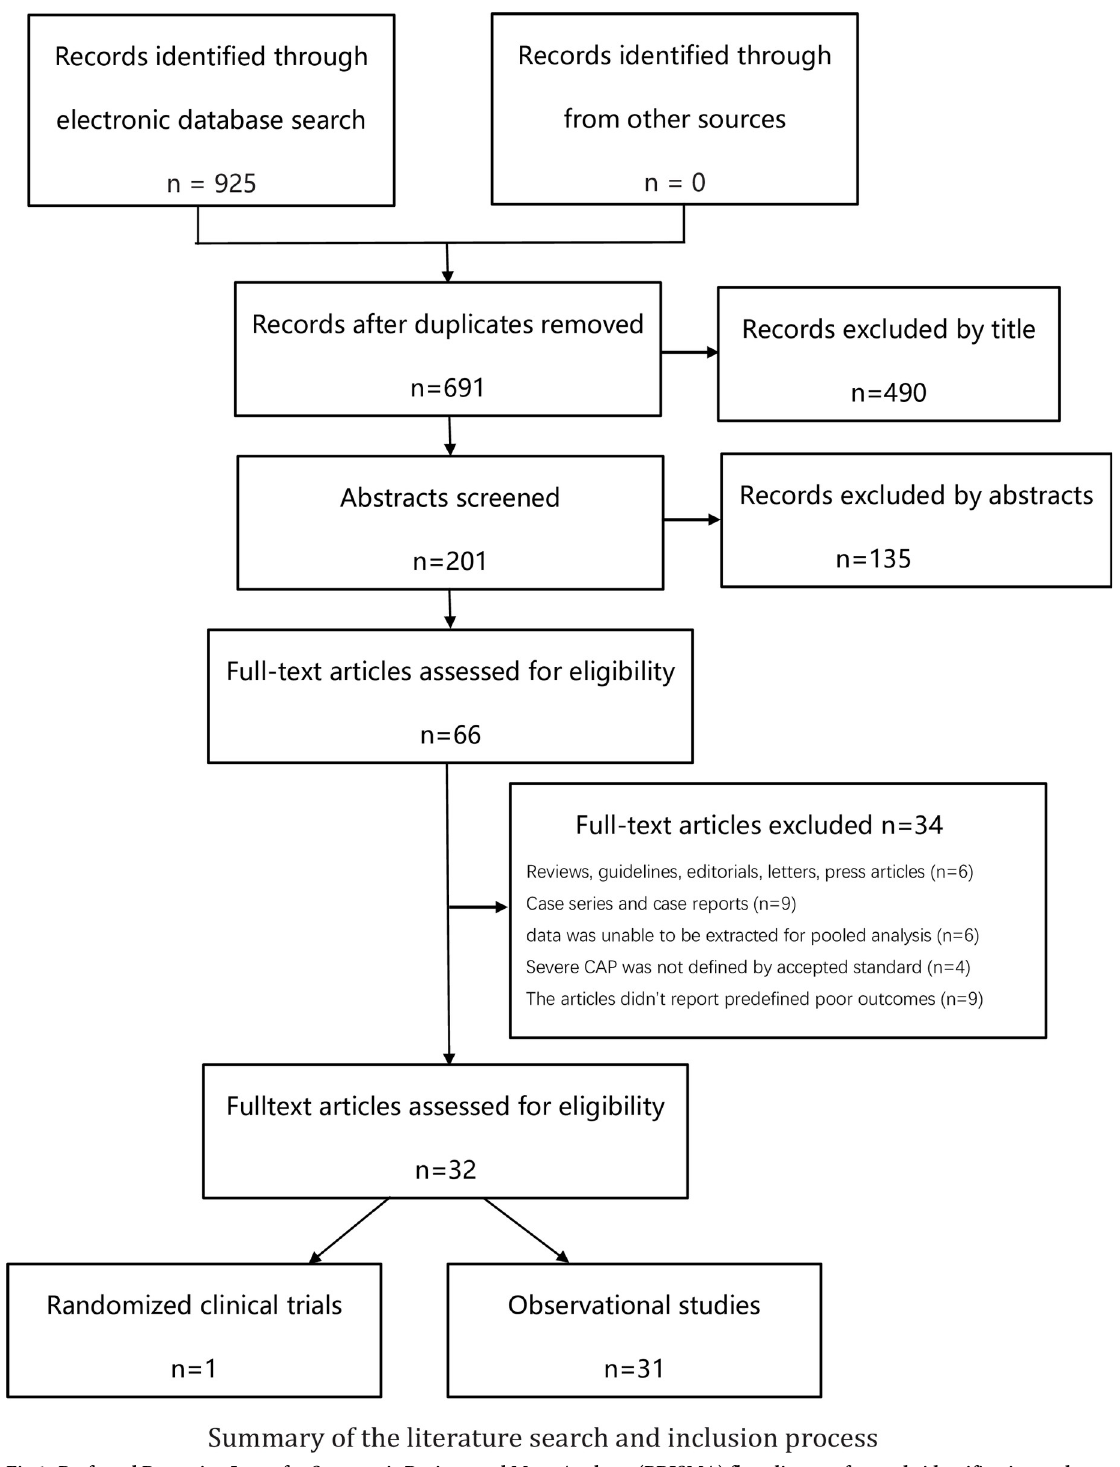
Fig 1. Preferred Reporting Items for Systematic Reviews and Meta-Analyses (PRISMA) flow diagram for study identification and selection.